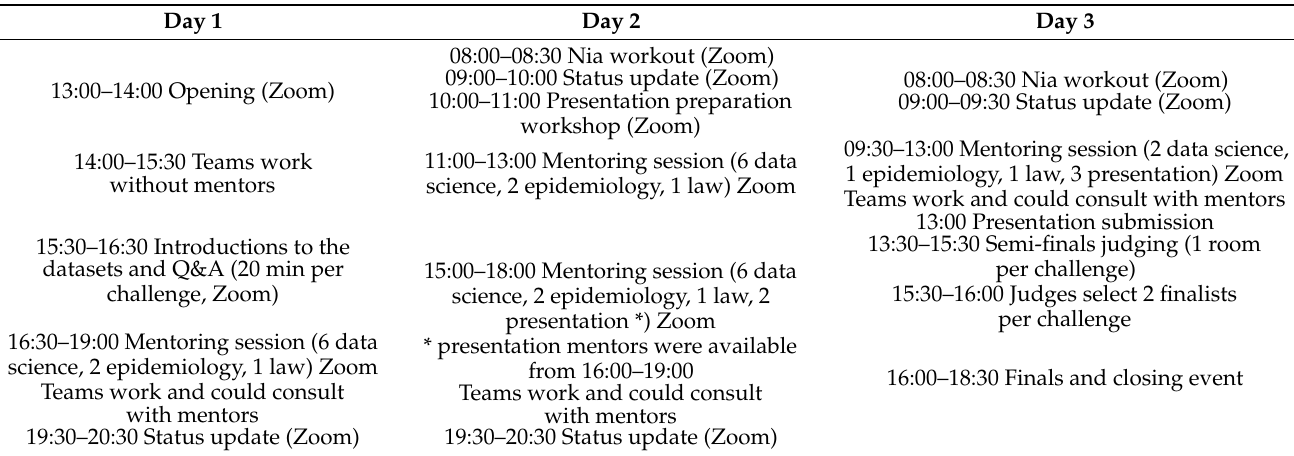
Table 3. Datathon